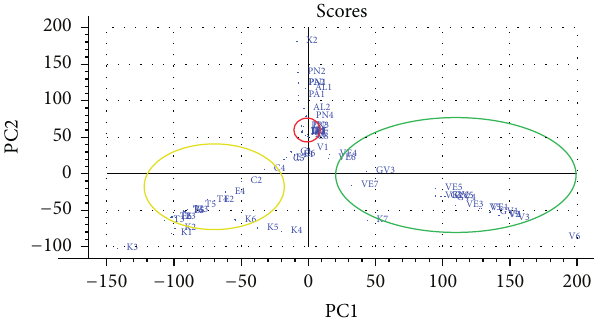
Figure 3: PCA scores of all samples. Matrix consisted of 63 samples and 112 ions. Important ions contributing to the new PCs according to the X-loadings are m/z 110, 152, 365, 366, 475, and 476. The red circleshowsibuprofencontainingmedicines,theyellowcircleshows tadalafil containing samples, and the green circle shows Viagra-type tablets. shows the PCA scores for all samples using the two first principle components, PC1 and PC2. The red ring circles the ibuprofen containing tablets which are mainly dependent on PC2. The yellow and green rings circle tadalafil containing tablets and the three different Viagra tablets, respectively. The latter are mainly separated based on PC1. APIs and/or